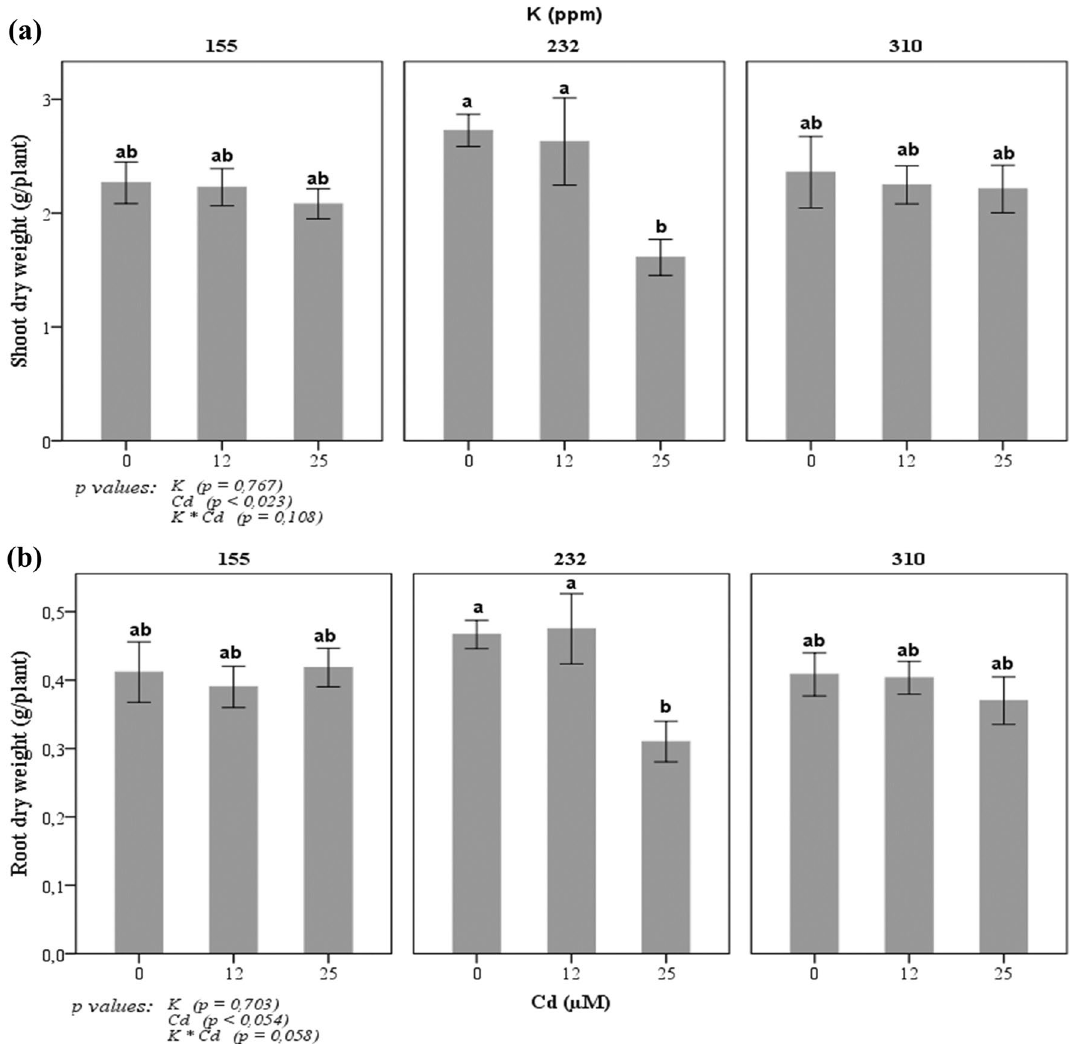
Figure 2. Changes in ( a ) shoot and ( b ) root dry weights of tomato plant in response to three potassium concentrations (155, 232, and 310 ppm) and three cadmium concentrations (0, 12 and 25 µM CdCl 2 ). Each value represents the mean ± SD of six independent repetitions, , dissimilar letters indicate significant differences at p < 0.05 according to Student–Newman–Keuls